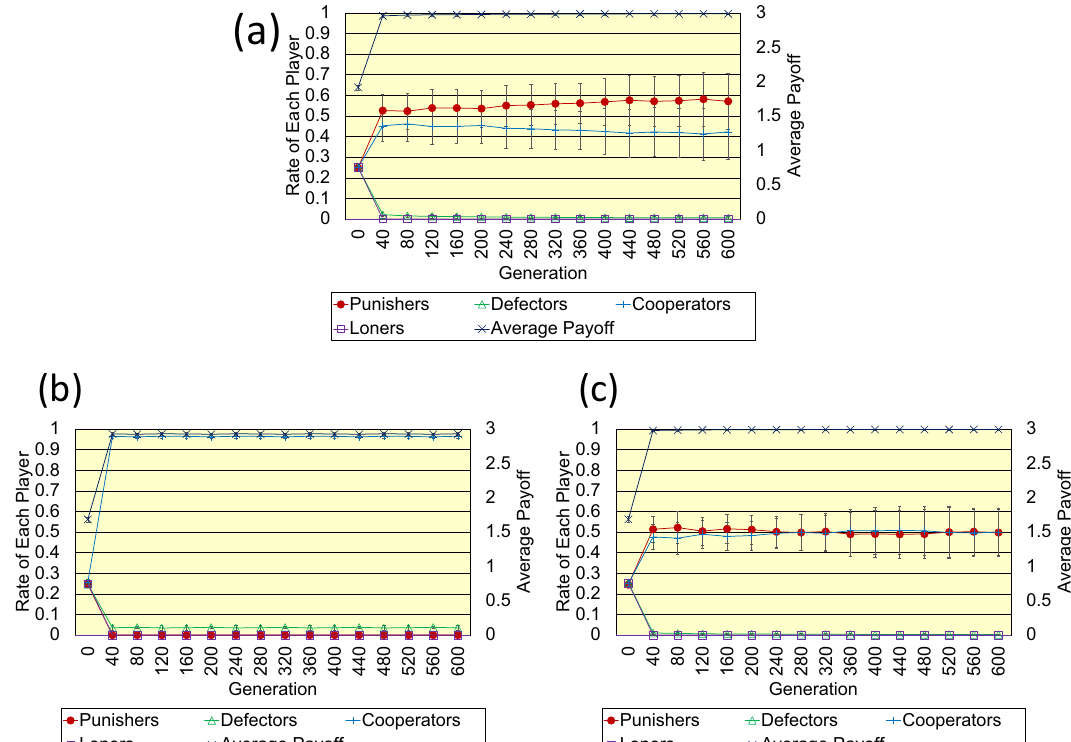
Figure 3. This figure shows the results regarding ( a ) the proposed pool punishment, ( b ) previous pool punishment, and ( c ) previous peer punishment on the regular one-dimensional lattice. Parameter settings are as follows; N = 1000, < k > = 4, n = 5, r = 3, c = 1, b = 1, g = 0.3, B = 1, G = 0.3, and σ =